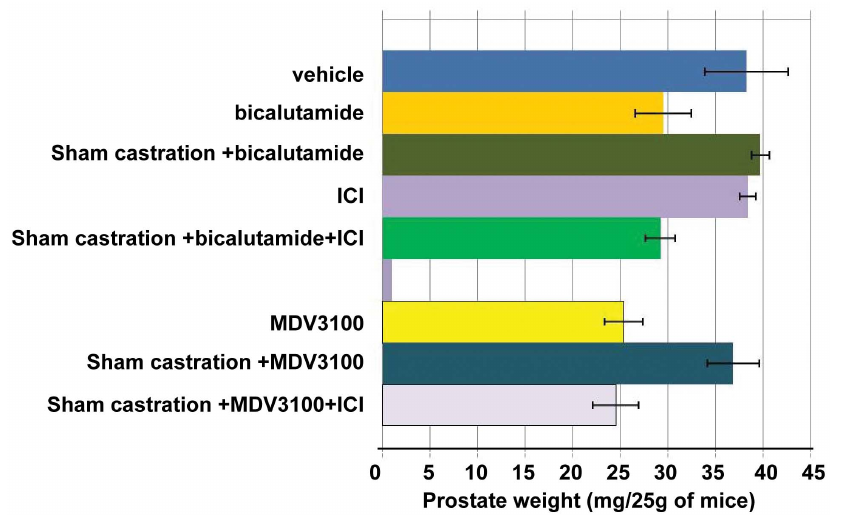
Figure 4. Surgical stress delays prostate involution induced by androgen ablation. C575BL/6J mice received subcutaneous injections of bicalutamide (50 mg/kg, once daily) and MDV3100 (10 mg/kg, once daily) with or without sham castration. ICI118,551 (ICI) was given 30 minutes before sham castration. 2 days later prostates were excised, dissected, and weighted. At least 3 mice were used for each data point. Error bars represent SD from the